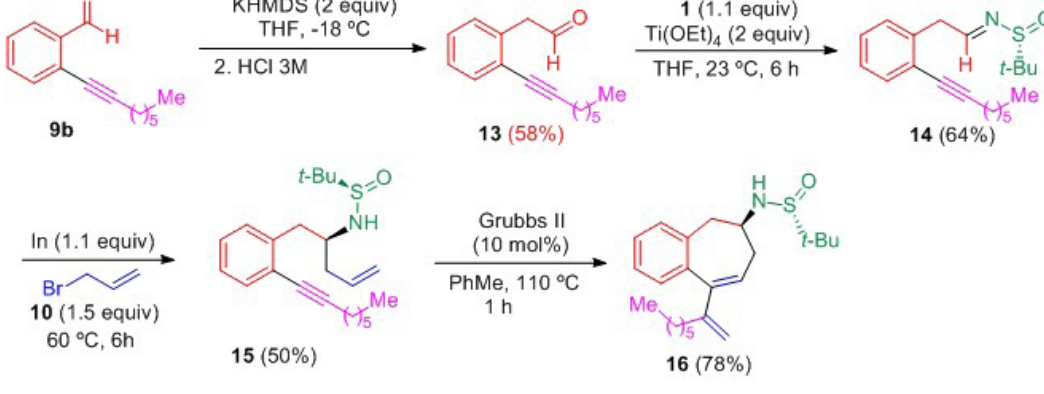
Figure 4 - Synthesis of diene 16 .